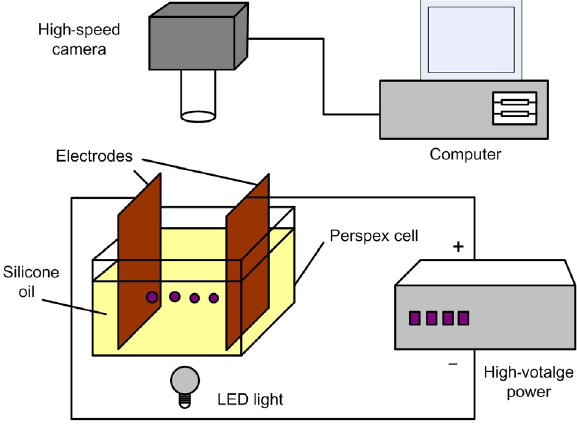
FIG. 6. Illustration of experiments 1, 2, and